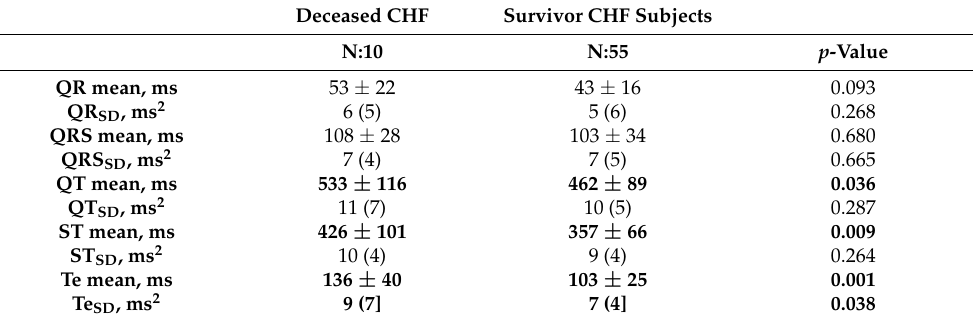
Table 4. Short-Period Repolarization Temporal Dispersion Variables in hospitalized Deceased and Survivor CHF patients.